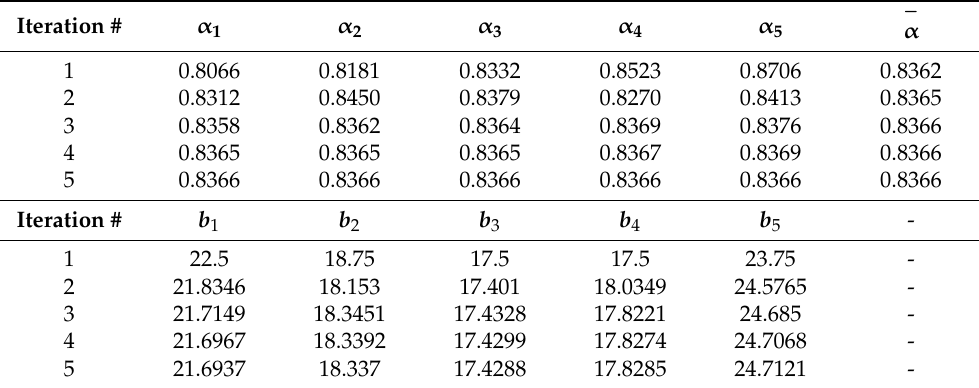
Table 12. Method application results for five coordination iterations.